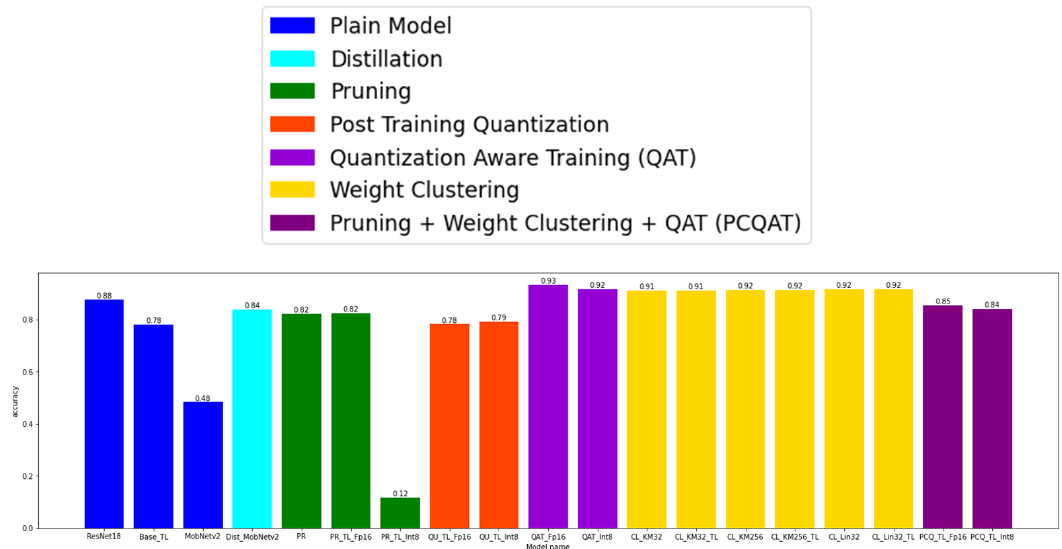
Figure A6. The accuracy of the model for the training and the validation datasets obtained during the training of the model with the weights clustered with KMeans++ initialization of 256 centroids. Further in the text, the results of the comparison(s) of the obtained models are presented (see Figures A7 and A8). The models that were created using the same compression method are colored with the same color. The colors are as follows: